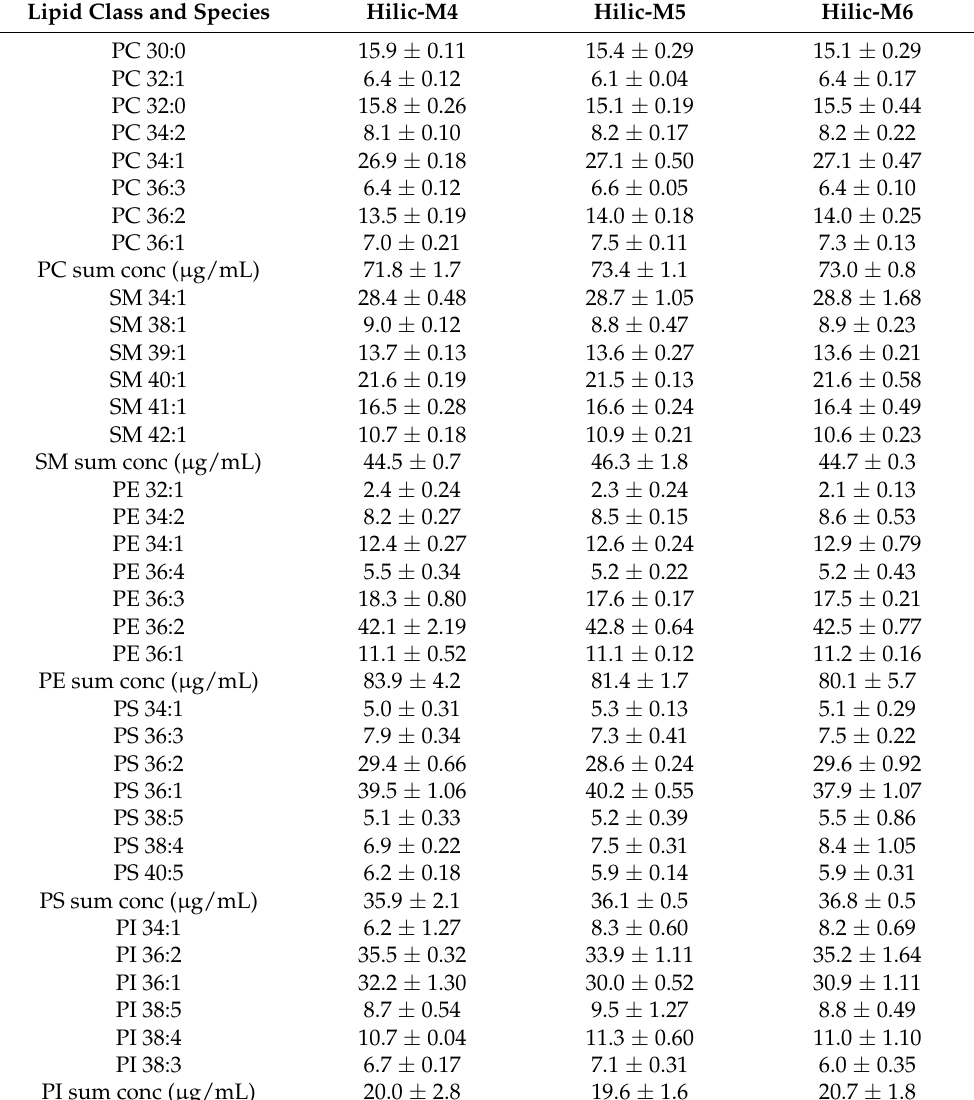
Table 5. Relative proportion (%) of species within each class and sum concentration of each phospho- lipid class of milk (Milk-11) as determined by 3 different LC elution gradients.